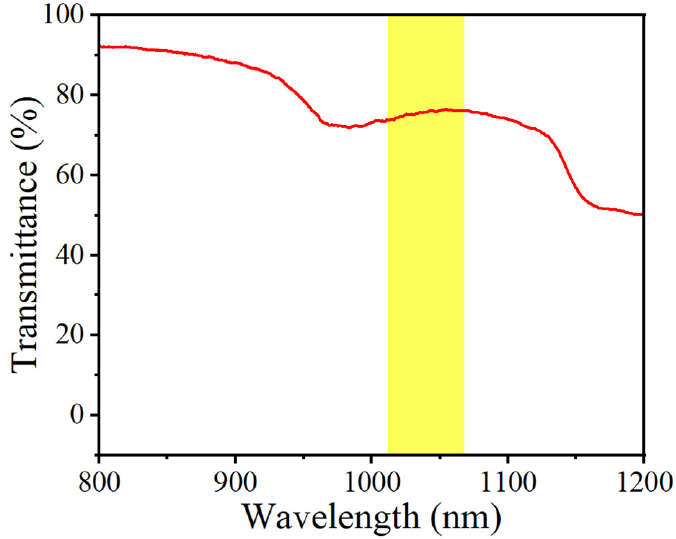
Figure 4. The transmission spectrum of the Fe 3 O 4 nanosheets.